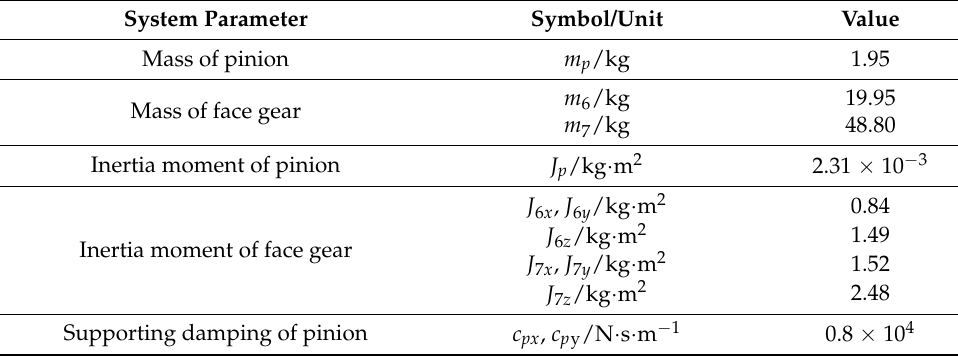
Table 3. Dynamic parameters of the face gear transmission system.